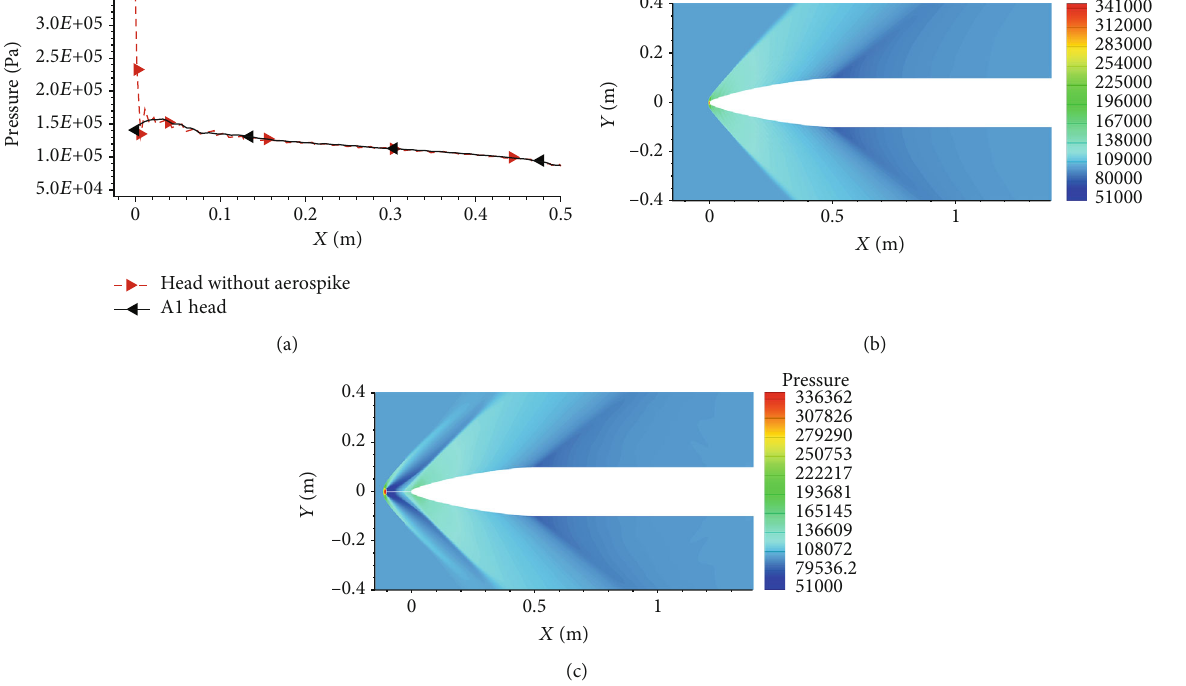
Figure 7: Head pressure and pressure contour for the basic model and A1. (a) Head pressure (b), pressure contour for the basic model, and (c) pressure contour for the A1.